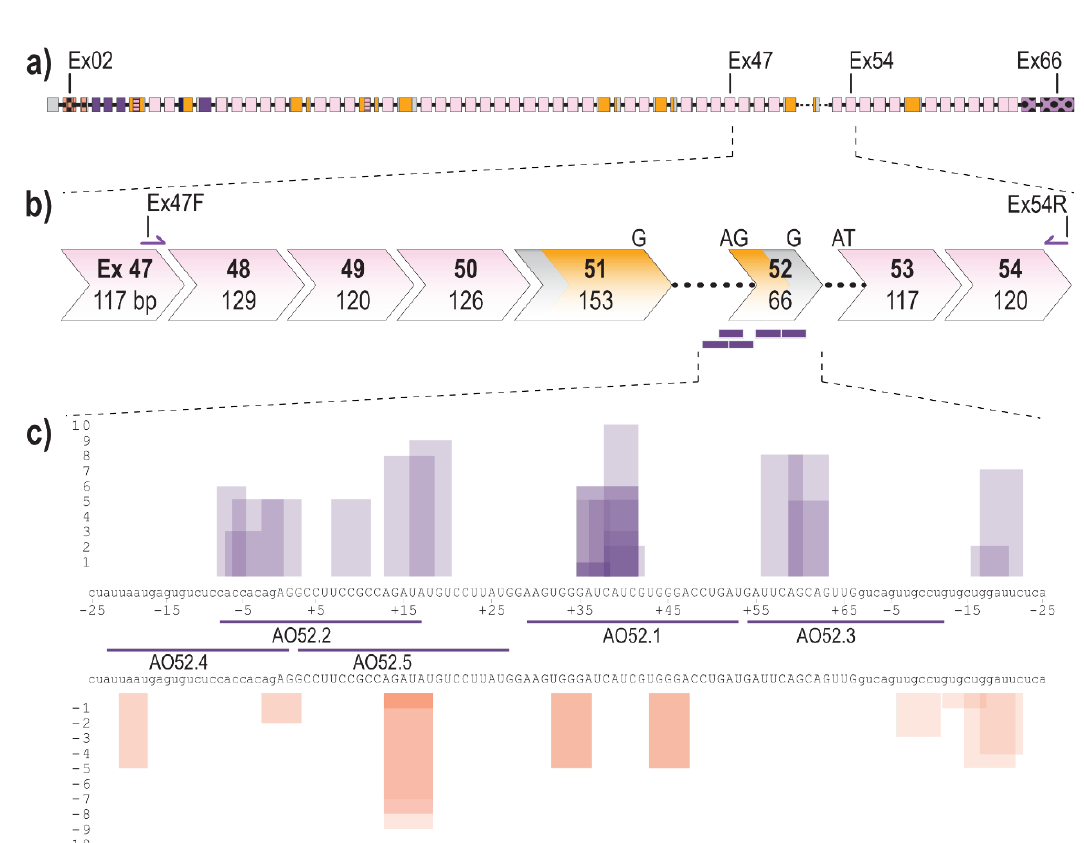
Figure 1. Schematic of FBN1 pre-mRNA highlighting the region between exons 47 and 54 as well as AO binding sites ( a ) Full fibrillin-1 pre-mRNA transcript with each box representing an exon. The solid black line represents introns (not to scale); ( b ) highlighting the region between exons 47 and 54; showing forward and reverse primers and antisense oligonucleotide binding sites (purple bars). Chevron sides indicate exons bounded by partial codons. Pink and yellow fill indicate regions encoding cbEGF-like and TB domains, respectively. The black dotted line indicates partial introns 51 and 52.; ( c ) Antisense oligonucleotide binding sites and the regulatory motifs they target predicted using spliceAid [58]. Each box represents a predicted enhancer (purple) or silencer (orange) site. The height of the box represents the strength of the site with 1 being the weakest and 10 being the strongest. Exonic and intronic sequences are shown in upper- and lower-case, respectively.